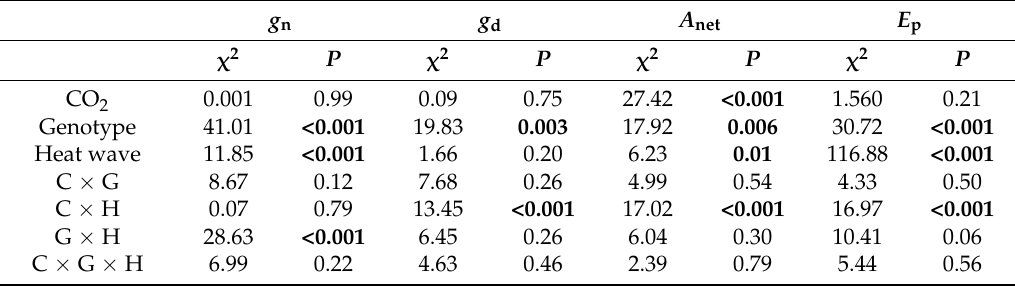
Results of linear mixed models on the effects of CO 2 , genotype, heat wave, and their interactions on nocturnal stomatal conductance ( g n ), daytime stomatal conductance ( g d ), leaf assimilation rates ( A net ), and whole plant transpiration ( E p ), with glasshouse bay nested within CO 2 concentration as random variables. P -values reflect the results of Wald tests on linear mixed model that included glasshouse bay nested within heat-wave treatment as random variables. Significant ( P < 0.05) values are in bold